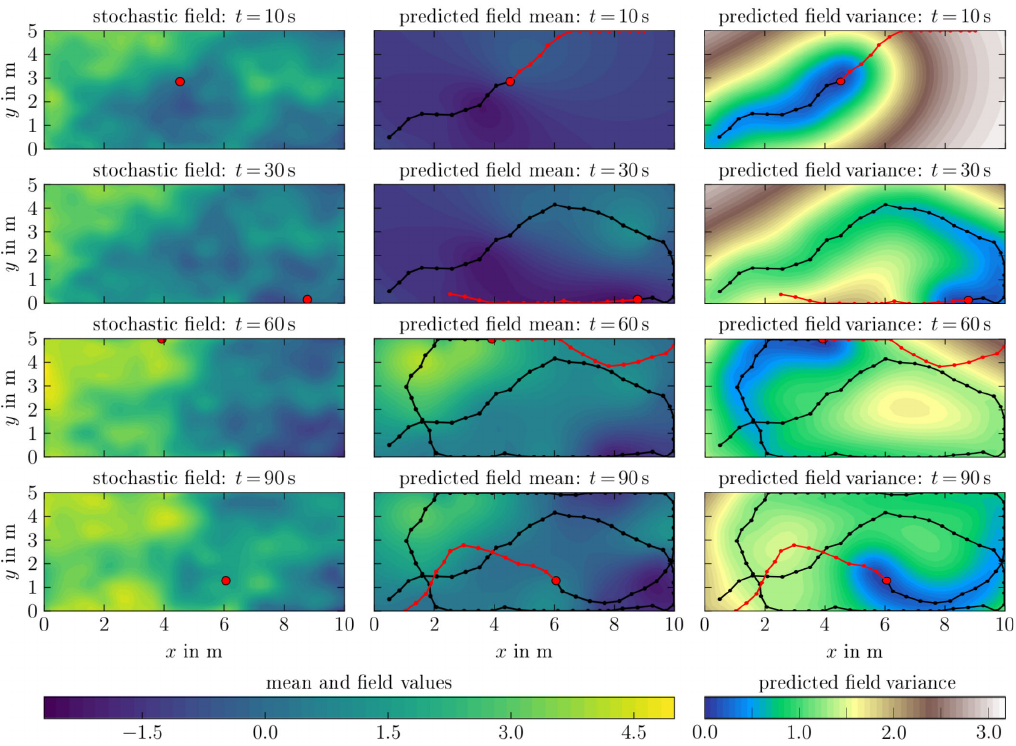
Figure 15. Agent-14 using the PI-STKF scheme with a control horizon of t H = 14s and temporal length scale of 15 5 resulting in a noticeable belief change over time, as represented by the increasing predicted field variance (left column). The agent collects measurements from an spatio-temporal concentration field to compute an optimal path ( | ) based on the predicted STKF field variance. The next position of the agent’s trajectory ( | ) is obtained by applying the first value of the computed optimal control sequence. Left: Spatio-temporal concentration field Center: Predicted field mean Right: Predicted field